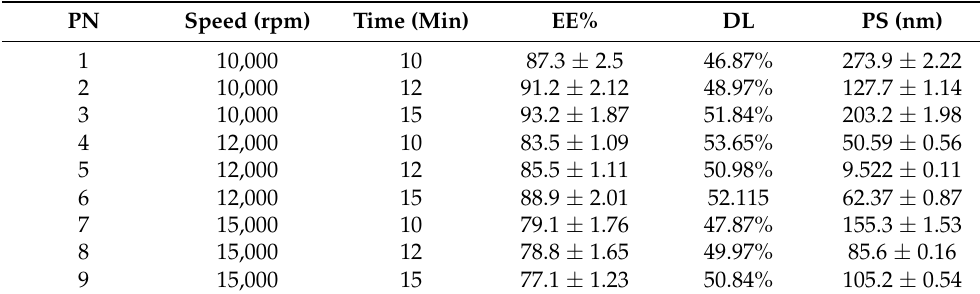
Table 1. Formulation parameters affect the particle size and entrapment efficiency.